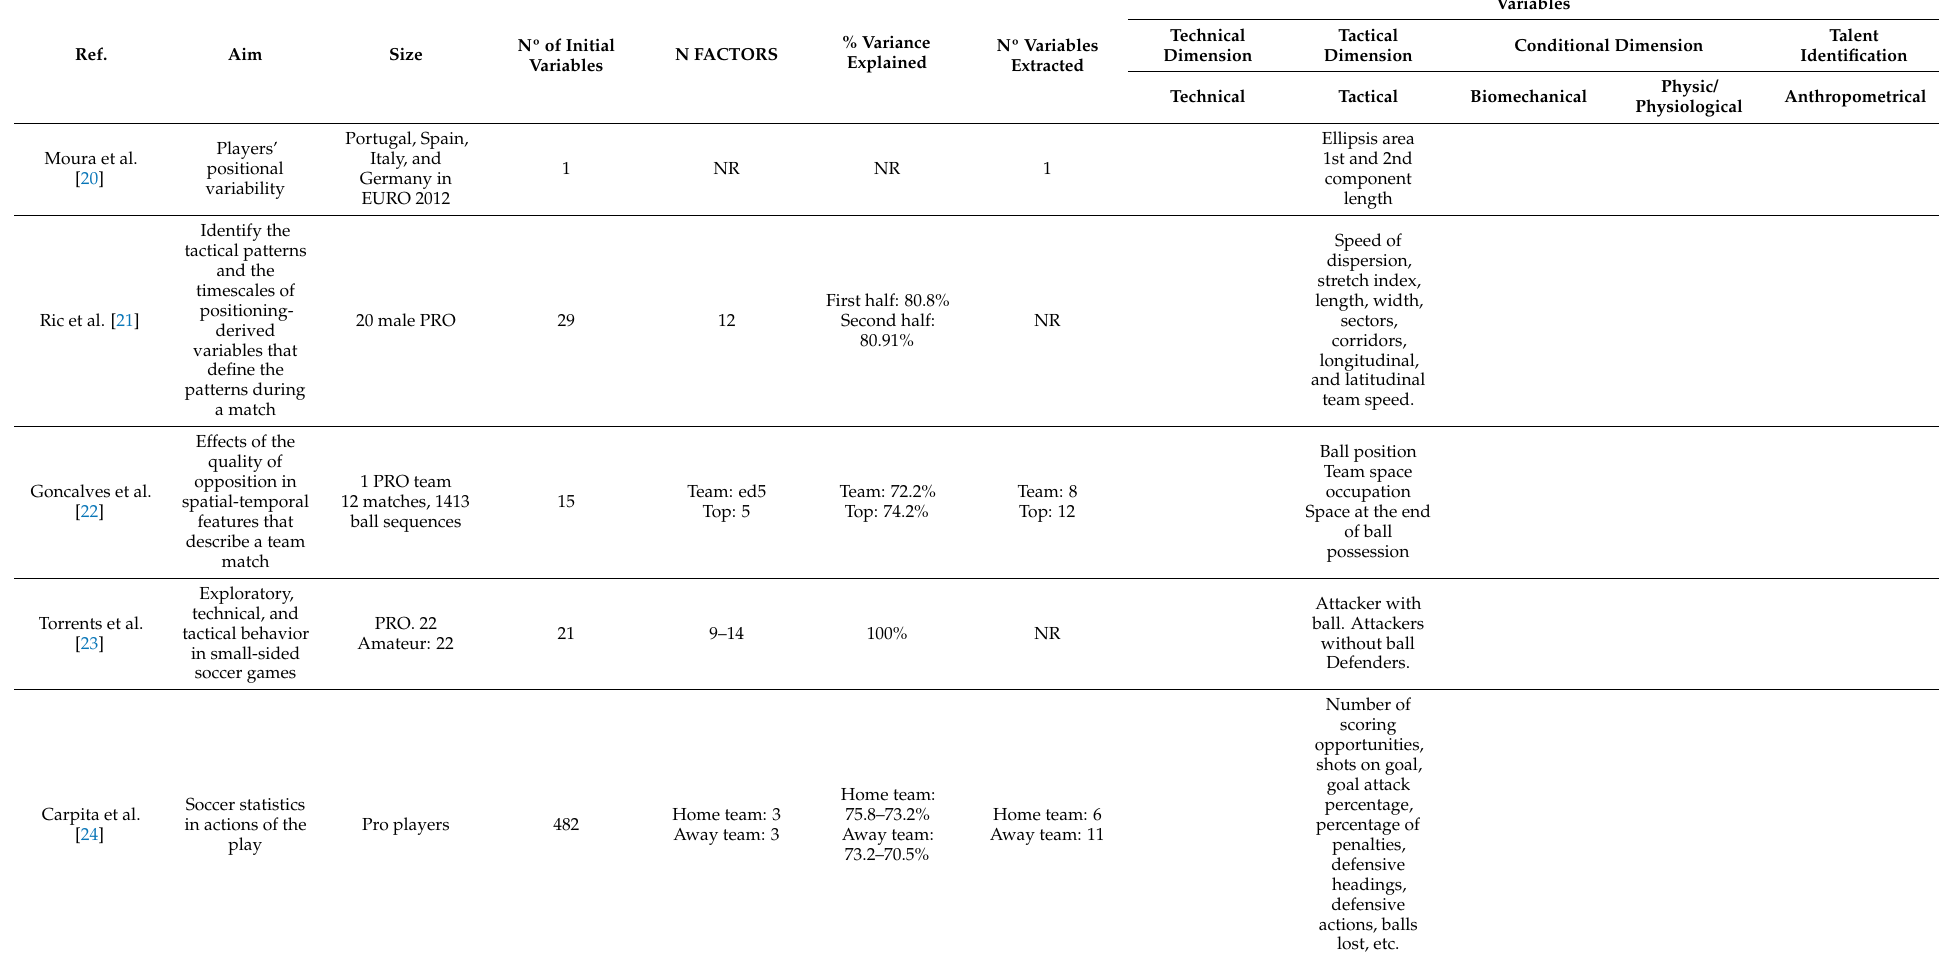
Table 1. Variables extracted through principal component analysis (PCA) in